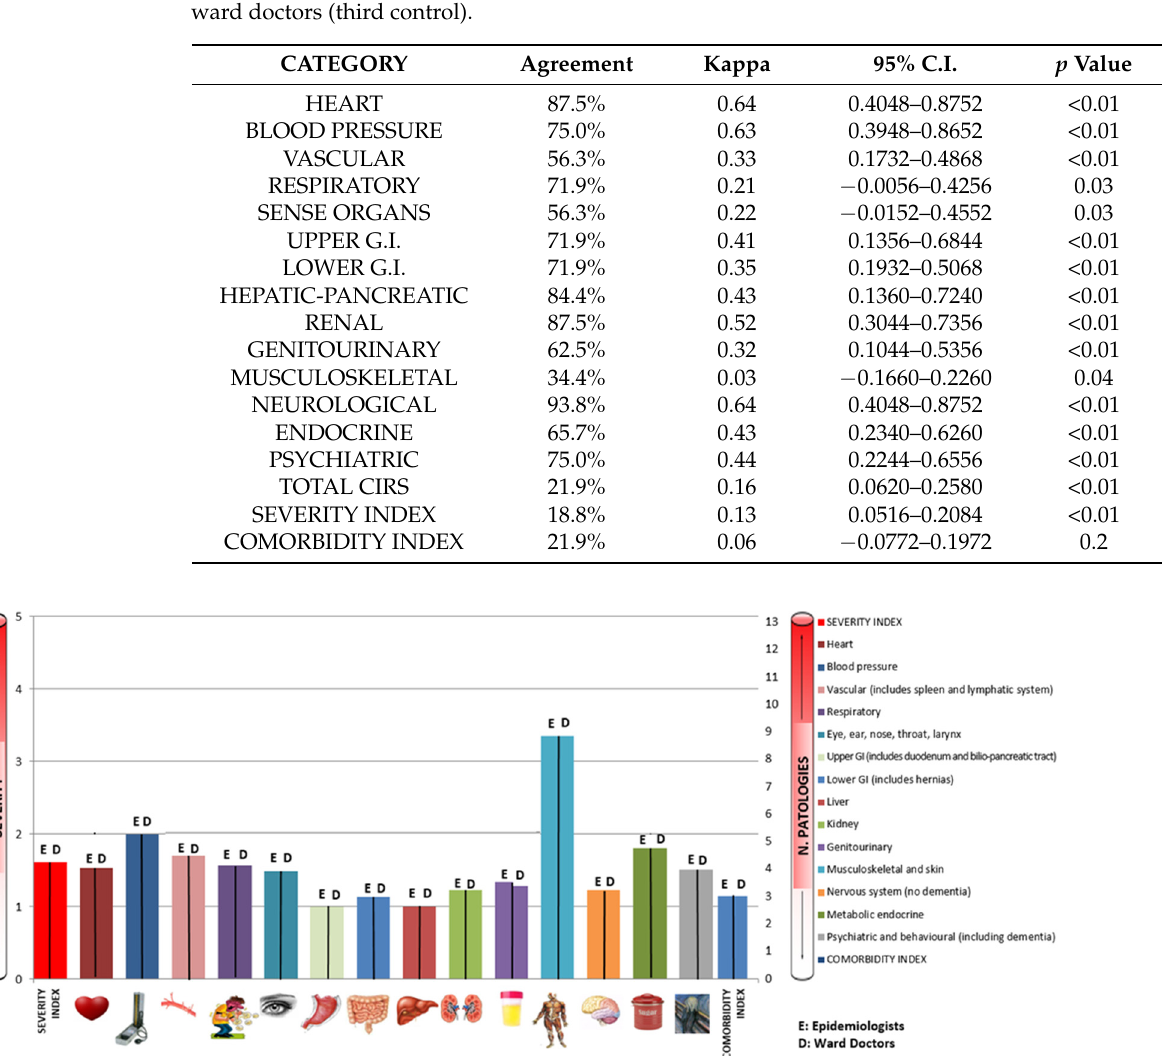
Figure 6. Concordance between epidemiologists and ward doctors (fourth control). Table 4. Levels of agreement between the CIRS values reported by the pool of epidemiologists and ward doctors (fourth control).